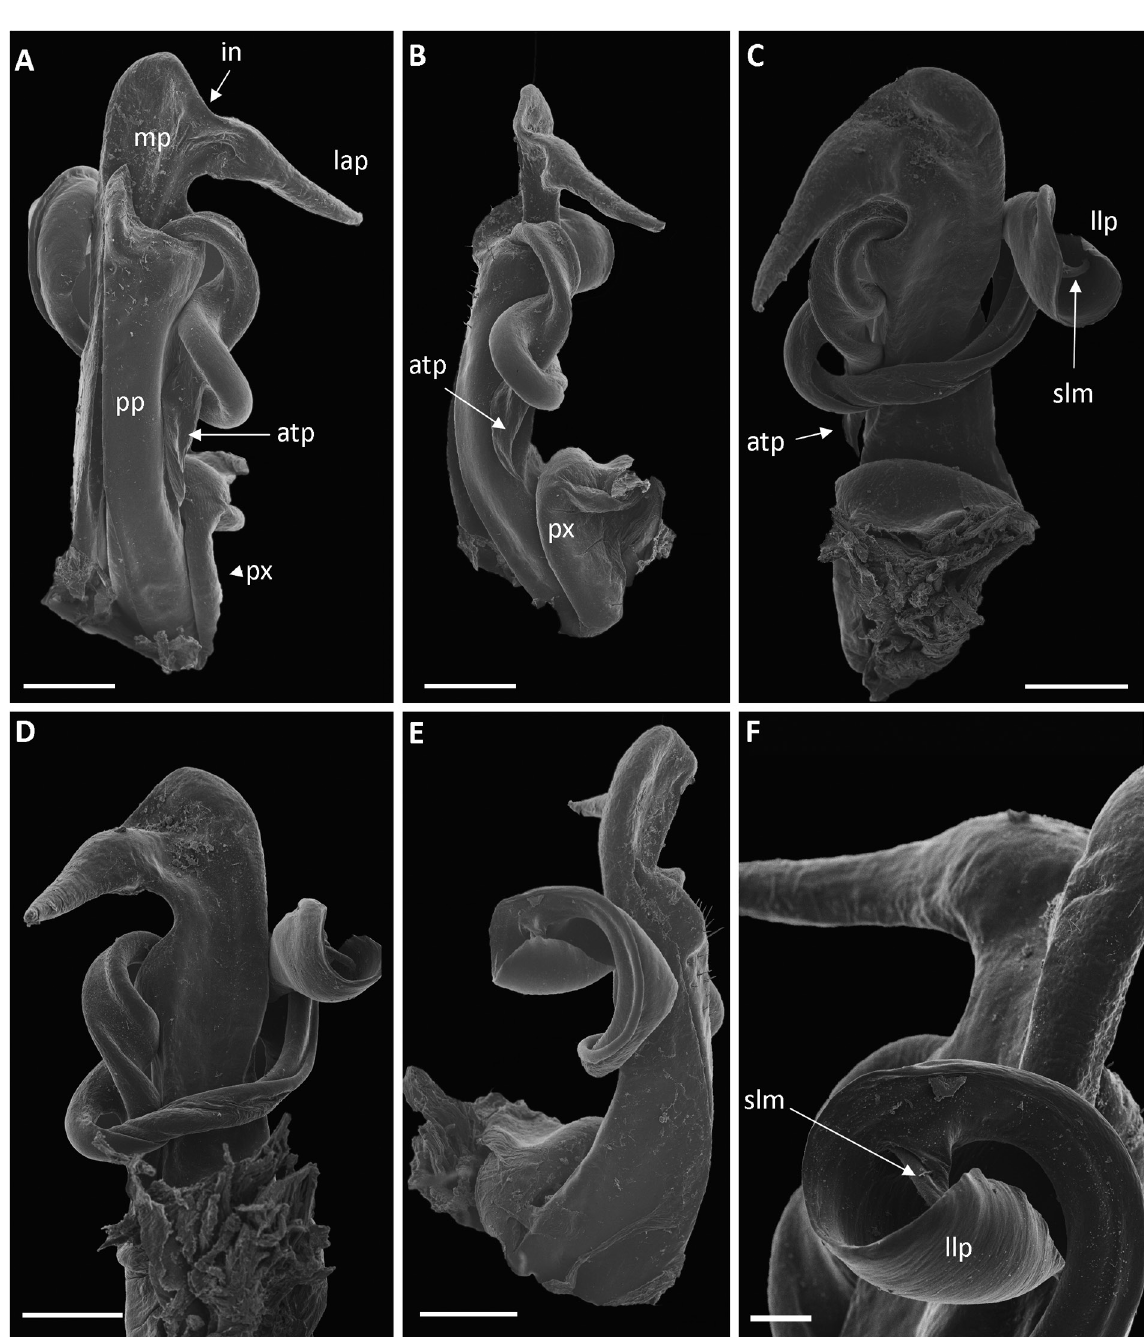
Fig. 2. Odontostreptus fadriquei sp. nov., holotype, ♂ (MZB 2003-1301), right gonopod. A . Anterior view. B . Lateral view. C . Oblique latero-posterior view. D . Posterior view. E . Mesal view. F . Meso- posterior view. Abbreviations: atp = antetorsal process; in = incision; lap = lateral metaplical process; llp = ladle-like process; mp = metaplica; pp = proplica; px = paracoxite; slm = solenomere. Scale bars: A–E = 0.2 mm; F = 0.1